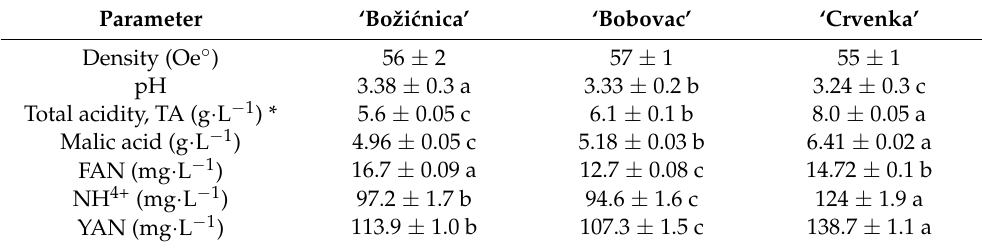
Table 1. Quality parameters of apple juices before fermentation.